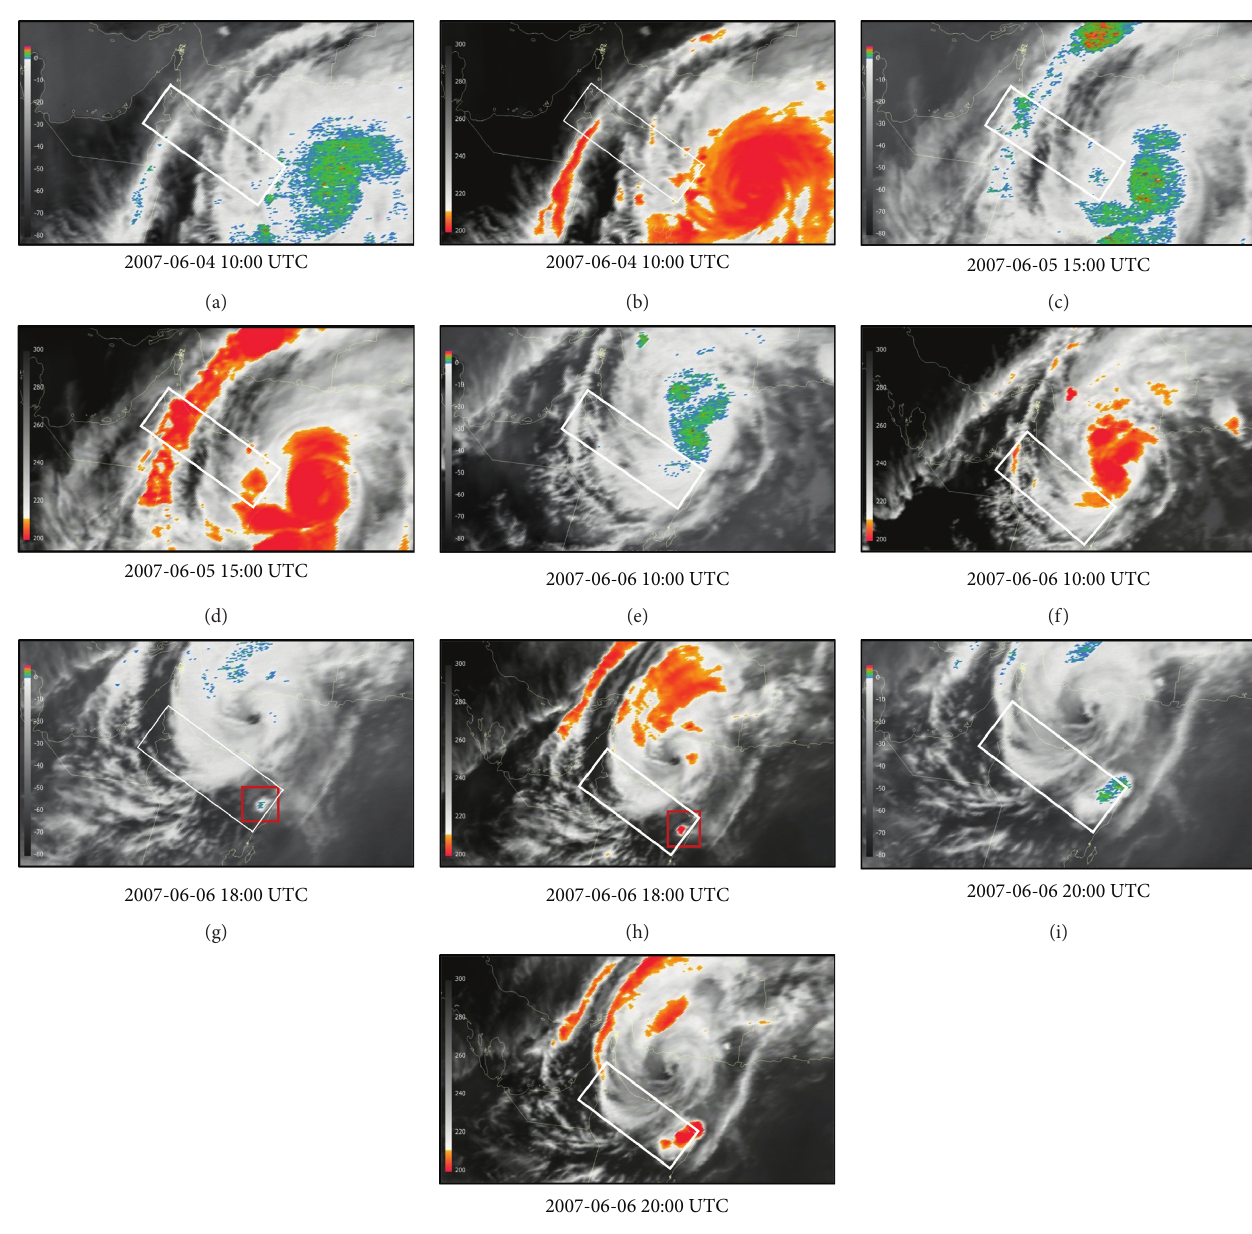
Figure 4: Sequence of BTD (WV6.2 μ m; IR10.8 μ m) (right) and coldest brightness temperature IR10.8 μ m (left) on 5th and 6th of